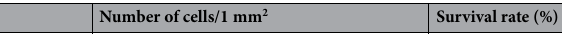
Total number of cells in the field of